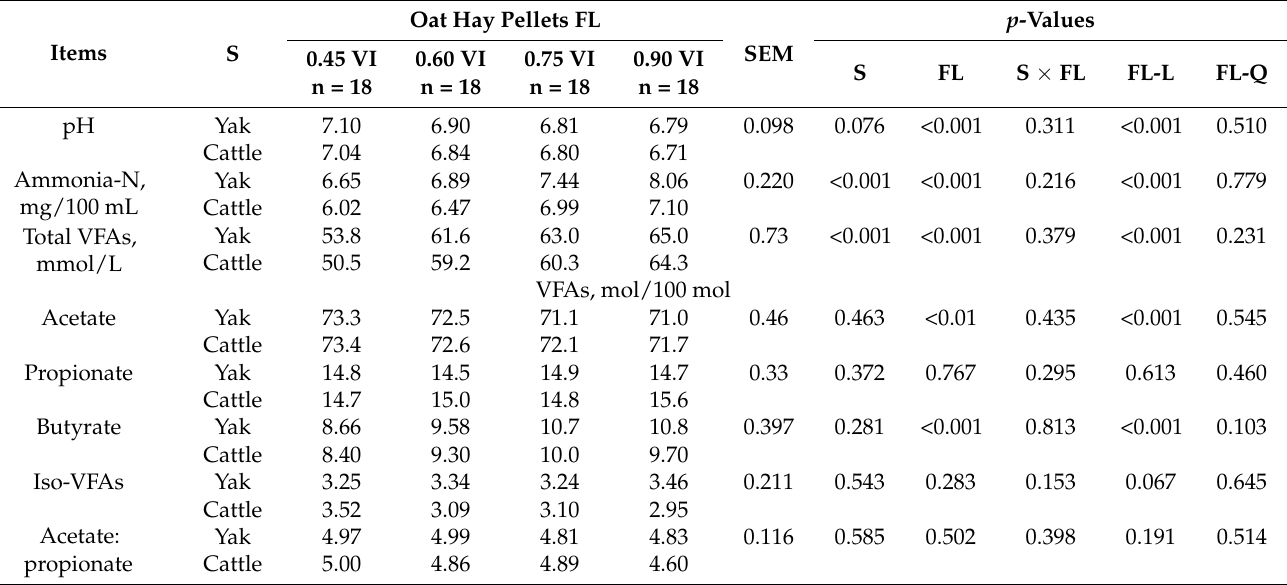
Table 4. The rumen fermentation parameters in yaks and in cattle offered oat hay pellets at different feeding levels.